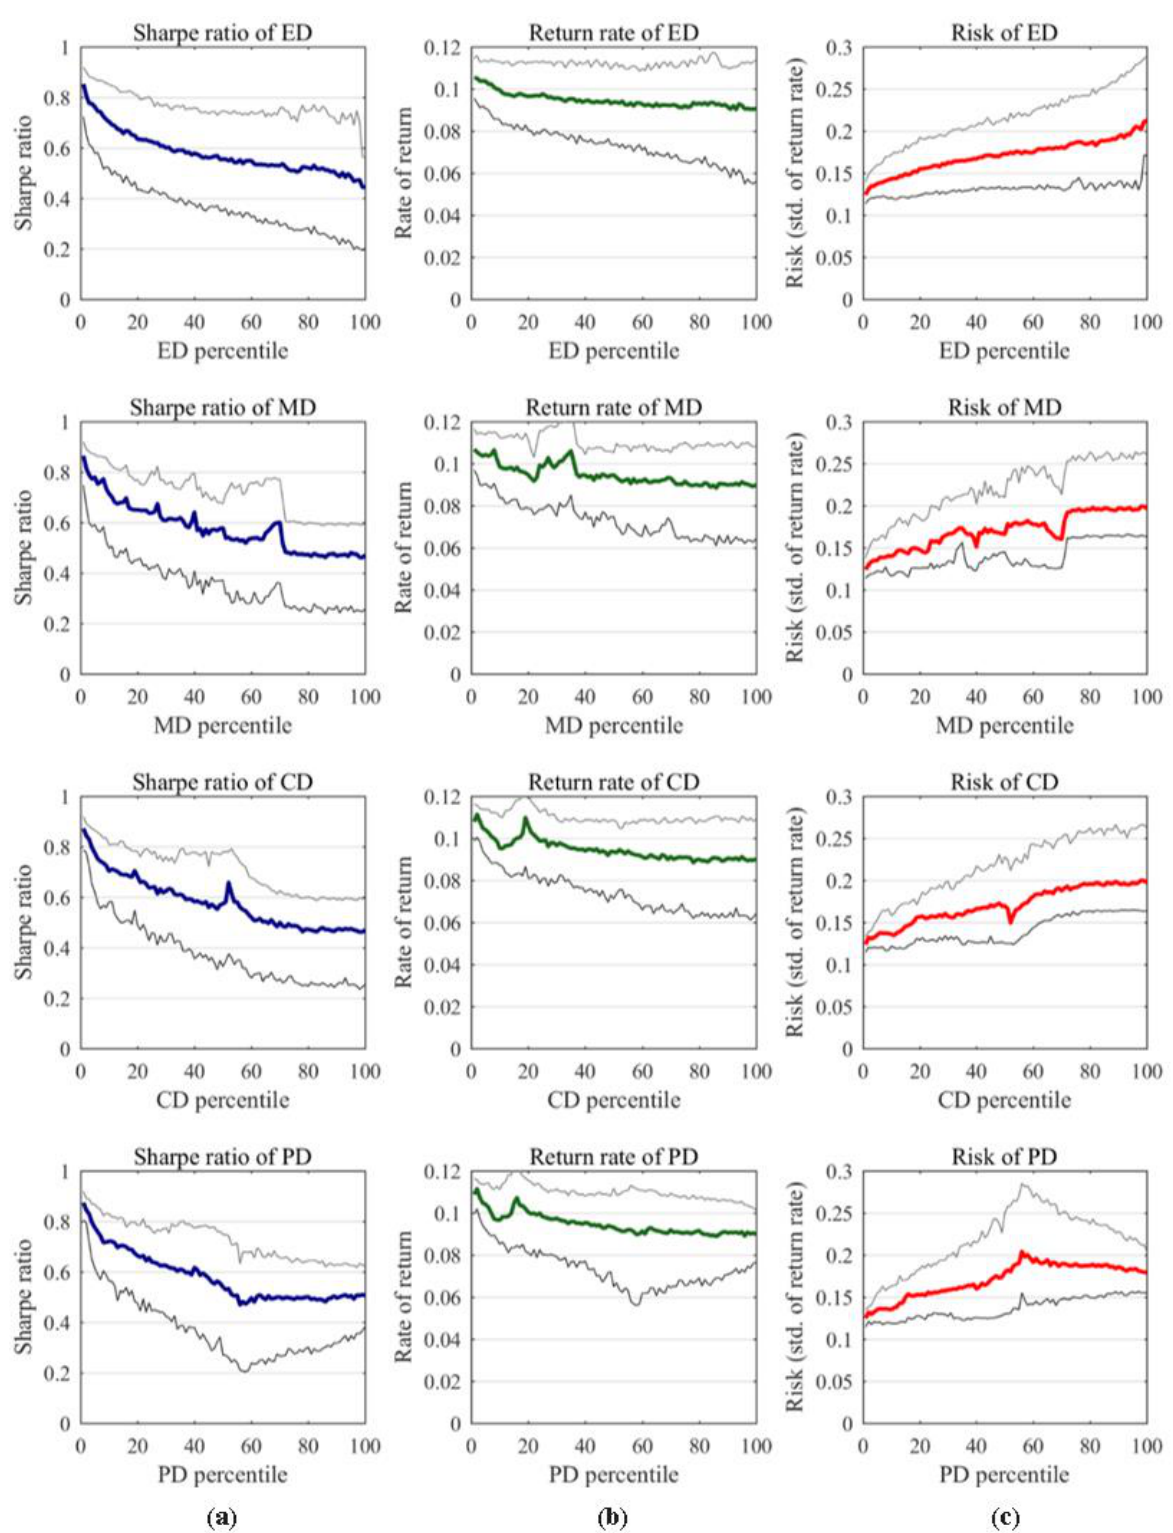
Figure 4. Changes in the average investment performance by the distance percentile group. ( a ) Sharpe ratio; ( b ) rate of return; ( c ) risk.